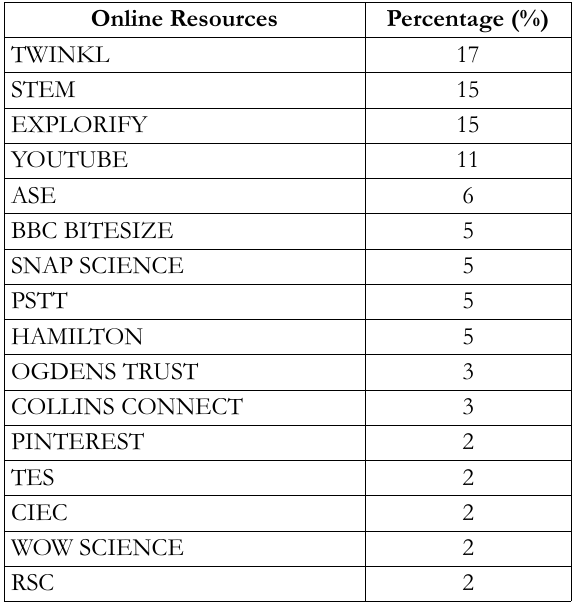
Table 12. Percentage of teachers’ responses to online resources (Questionnaire)